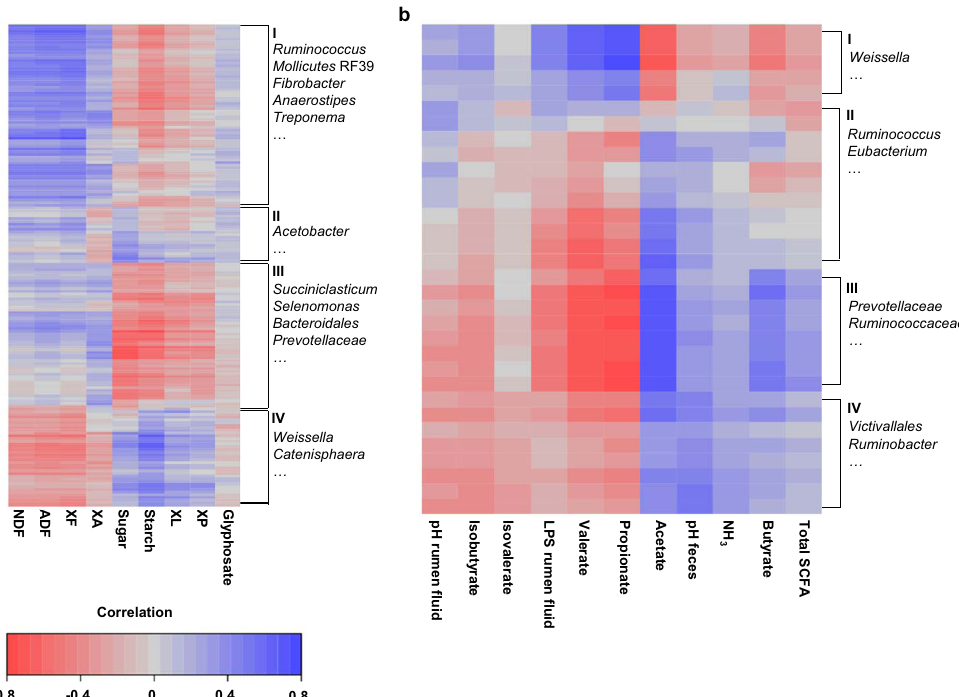
Fig. 7 PLS of ruminal microbiota with feed intake and microbial products in the rumen. Clustered image maps of PLS analyses comparing dietary component intake and glyphosate exposure with rumen microbial taxons ( a ) and rumen microbial taxons with microbial products in the rumen and pH of rumen fl uid and feces ( b ). NDF: neutral detergent fi ber, ADF: acid detergent fi ber, XF: crude fi ber, XA: crude ash, XL: crude fat, XP: crude